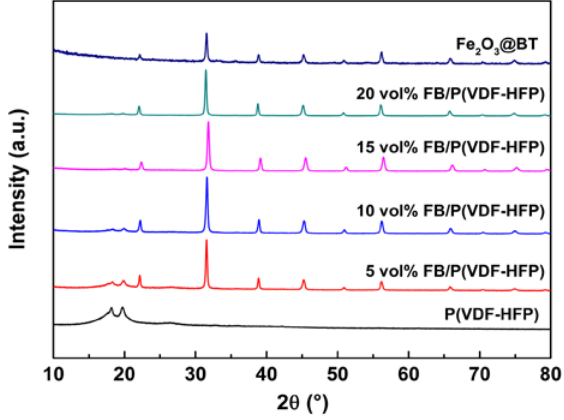
Figure 5. XRD patterns of P(VDF-HFP), Fe 2 O 3 @BT nanoparticles, and FB/P(VDF-HFP)